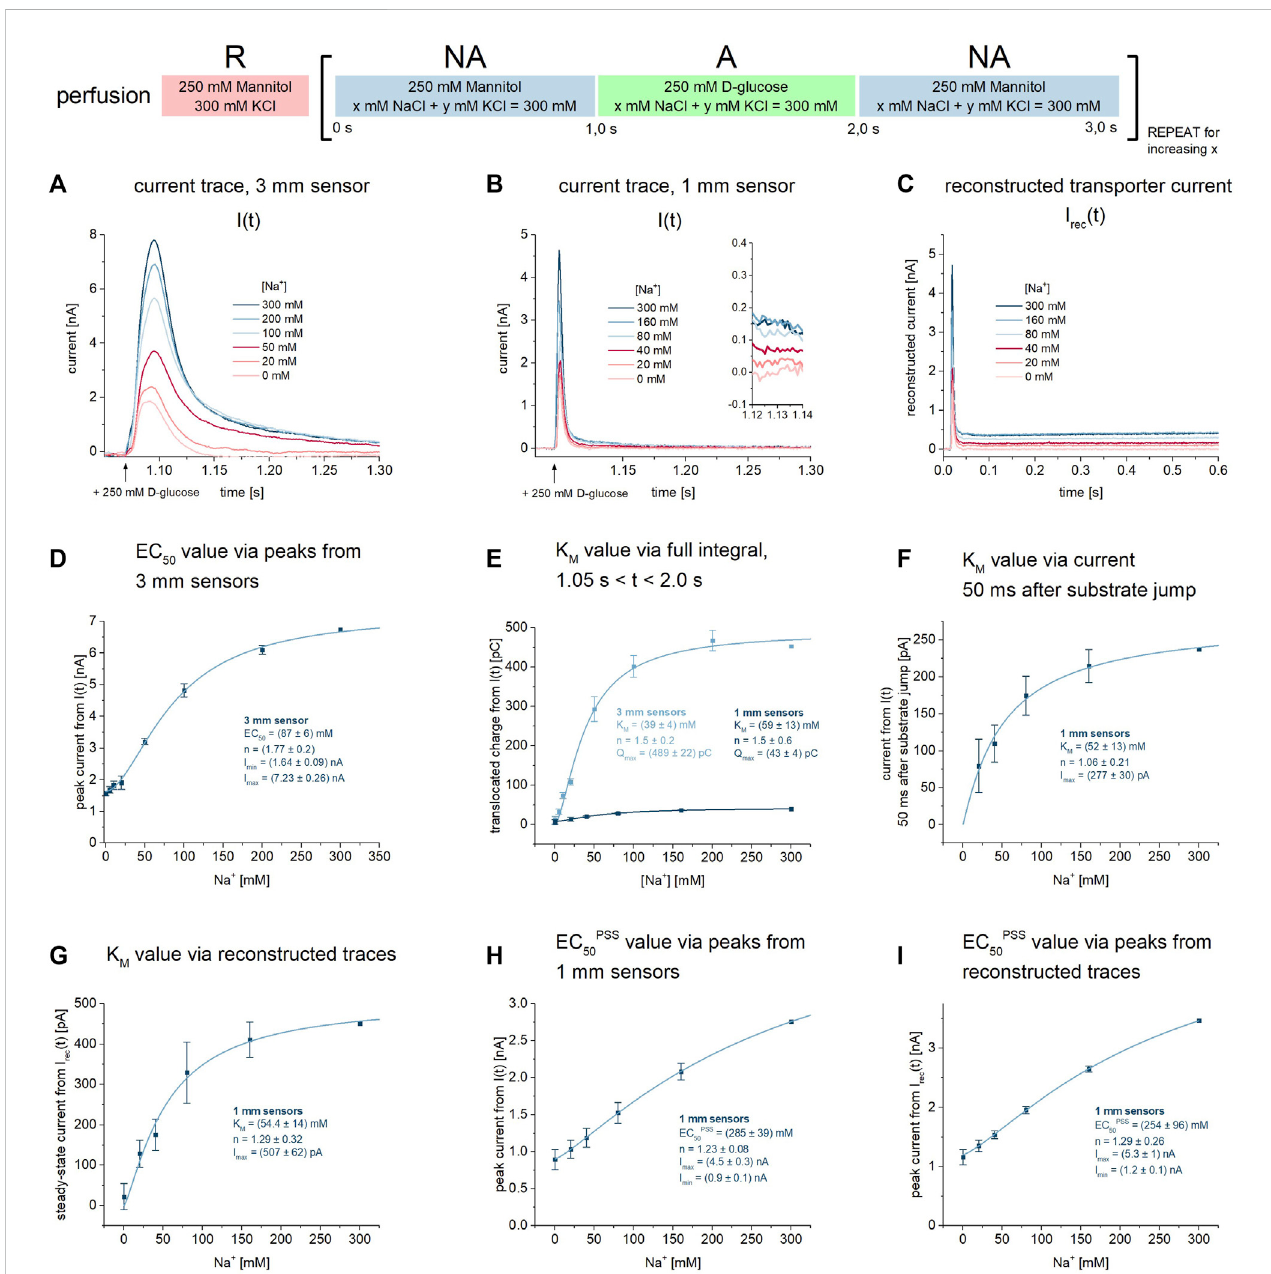
FIGURE 3 K M andEC 50 PSS valuesforNa + duringNa + /D-glucosecotransport.Allcurrenttraceswererecordedon3 mmor1 mmsensorsasindicated,equilibratedatpH7.4in thepresenceof0 – 300 mMNa + inallmeasurementsolutionsandupon250 mMD-glucoseconcentrationjumps.Averageddataof n =6differentsensorsisshown. FurtherdetailsarefoundinthedescriptionofFigure1. (A) Representativecurrenttracesrecordedonone3 mmsensor. (B) Representativecurrenttracesrecordedon one1 mm sensor. Theinset showsthecurrent at t = 1.13 susedfortheanalysisin(F). (C) Via circuitanalysis,transporter currentswere reconstructed from the current traces shown in (B) (Tadini-Buoninsegni and Fendler, 2015). (D) Peak currents from 3 mm sensors are fi tted using a hyperbolic equation to derive an EC 50 of 87 ± 6 mM for Na + . It represents a value which is between K M and the EC 50 of the D-glucose induced PSS current, since the peak is affected by both D-glucose induced PSS and transport phases. (E) Integrals from 3 mm to 1 mm sensors are fi tted using a hyperbolic equation to derive K M values of 39 ± 4 mM and 59 ± 13 mM for Na + , respectively. (F) Currents at t = 1.13 s are fi tted using a hyperbolic equation to derive a K M of 52 ± 13 mM for Na + . (G) Steady-state currents from the reconstructedtransporter currentsare fi tted using a hyperbolicequationto derive aK M valueof 54.4 ± 14 mM for Na + . (H) Peak currents from 1 mm sensors are fi tted using a hyperbolic equation to derive an EC 50 PSS of 285 ± 39 mM for Na + . Since peaks are dominated by D-glucose binding induced PSS currents, the determined EC 50 may not represent a K D for Na + but is rather limited by sugar binding kinetics. (I) Peak currents from the reconstructed transporter currents are fi tted using a hyperbolic equation to derive an EC 50 PSS of 254 ± 96 mM for Na +